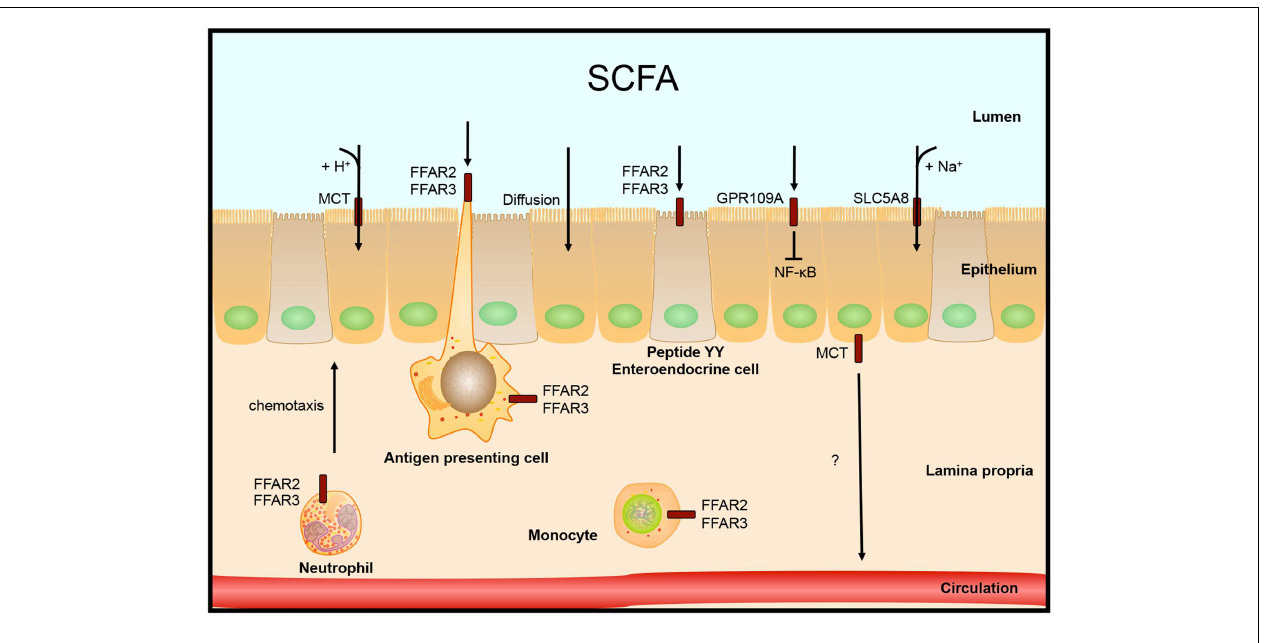
Other receptors that are activated by SCFA are localized on colonocytes, peptideYY expressing enteroendocrine cells, or different immune cells. Receptor FFAR2 is involved in neutrophil chemotaxis toward sources of